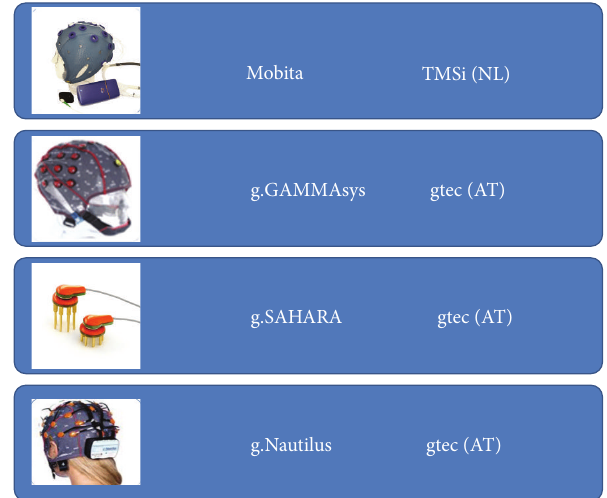
Figure 3: Overview of electrode